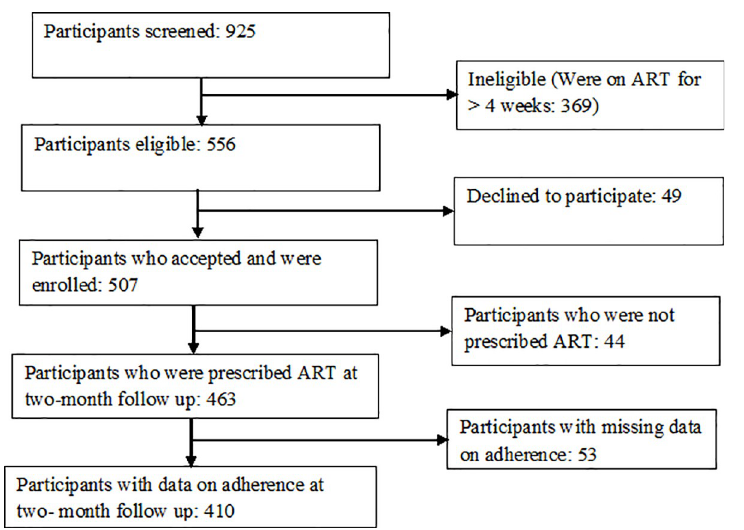
Fig 1. Flow chart for enrolment and two- month follow-up of the study participants.